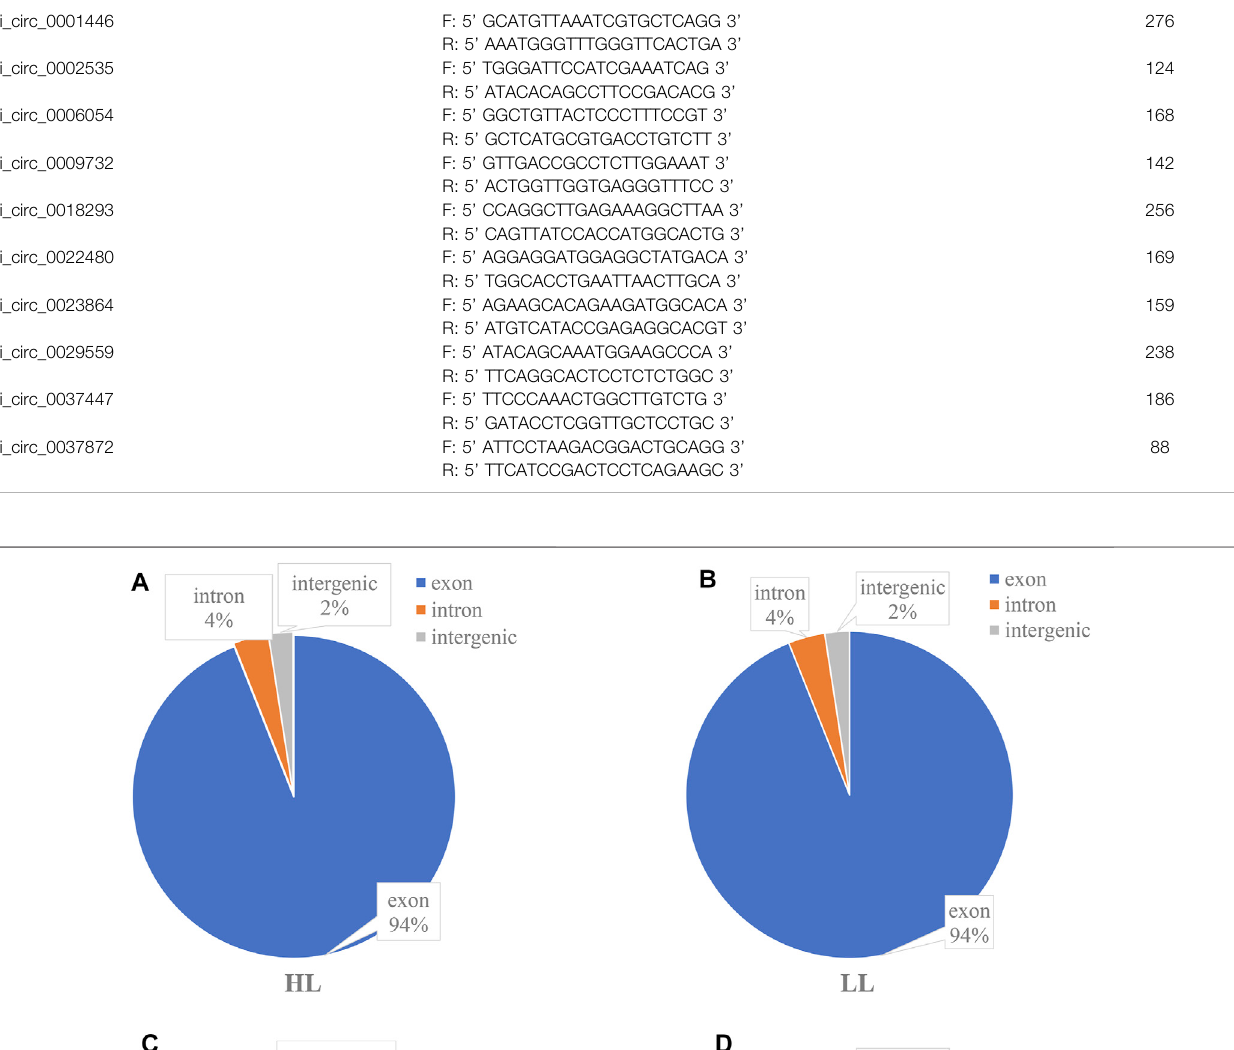
Frontiers in Genetics |